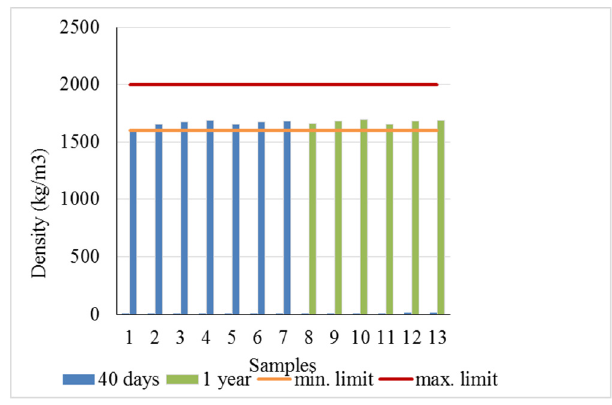
Figure 4. Apparent density of mixtures.